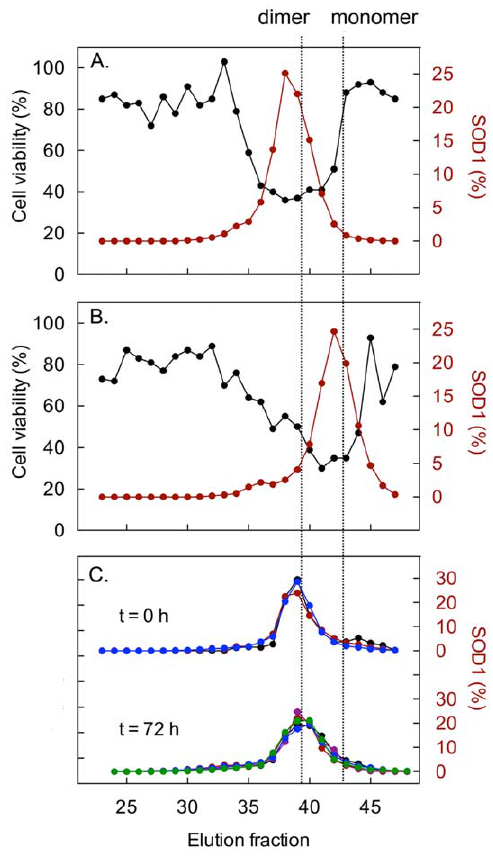
Figure 2. The apoSOD1 molecules do not self-assemble in the cell culture media. Dimeric and monomeric apoSOD (25 m M) were applied to a Superdex 75 column and the eluted fractions were tested for cytotoxicity in SH-SY5Y cells (black) and analysed for SOD1 by western immunoblotting (red). Cell viability was measured with the resazurin assay and presented as percentage viability of buffer control. The peak areas from the western blot analysis have been normalised to total amount of SOD1 in the chromatography. Cytotoxicity coincides with the dimeric ( A ) and monomeric ( B ) peaks of the chromatograms. ( C ) Analysis of the cell-culture medium directly after protein addition of dimeric apoSOD1 and after 72 h incubation confirms that the apoSOD1 molecules remain dimeric throughout the toxicity assay. Large molecules and aggregates would elute in the void volume of the Superdex-75 column around fraction 26. The concentration of SOD1 in the culture medium was varied between 0.16 m M (black), 0.625 m M (purple), 1.25 m M (red), 2.5 m M (blue) and 12.5 m M